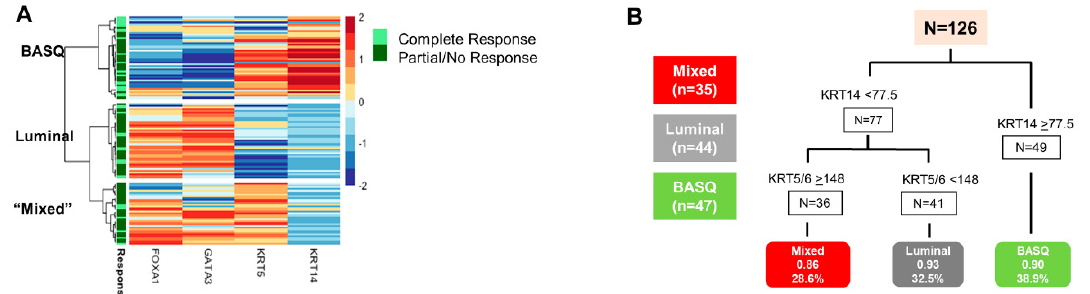
Figure 2. Expression of FOXA1, GATA3, KRT5 / 6 and KRT14 in the three tumor subtypes. The heatmap depicts the relative biomarker expression. ( A ) Clusters resulting from the KRT5 / 6, KRT14, GATA3, and FOXA1 tumor histoscore. ( B ) Classification and regression trees (CART) model showing the optimal accuracy of the cluster classification. The numbers in the bottom boxes are the proportion of the observed clusters predicted and the percentage of UBC s each class represents.